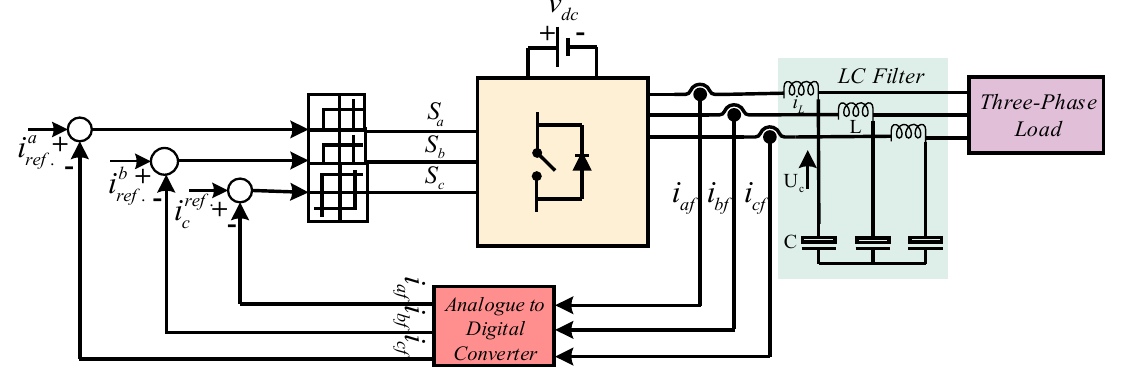
Figure 25. A Hysteresis control technique for VSI.